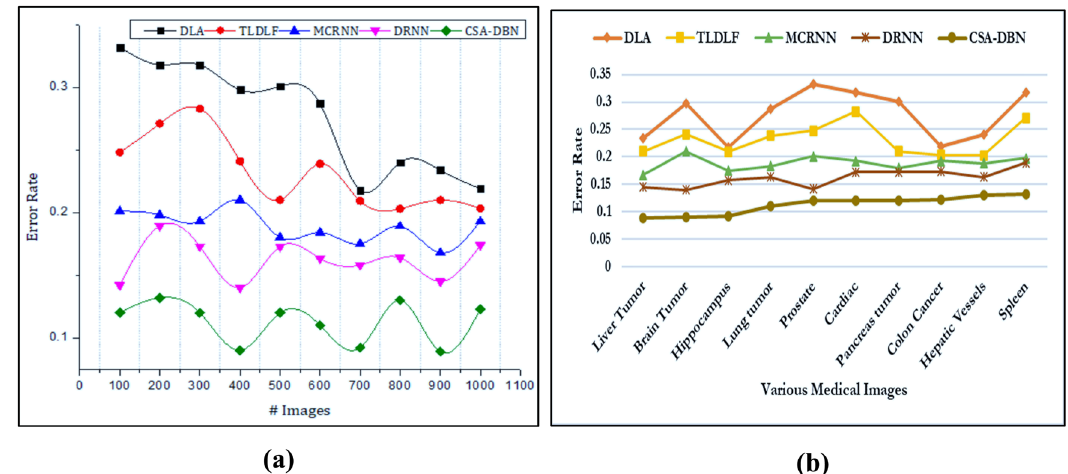
Figure 8: Error value analysis: ( a ) # images and ( b ) di ff erent